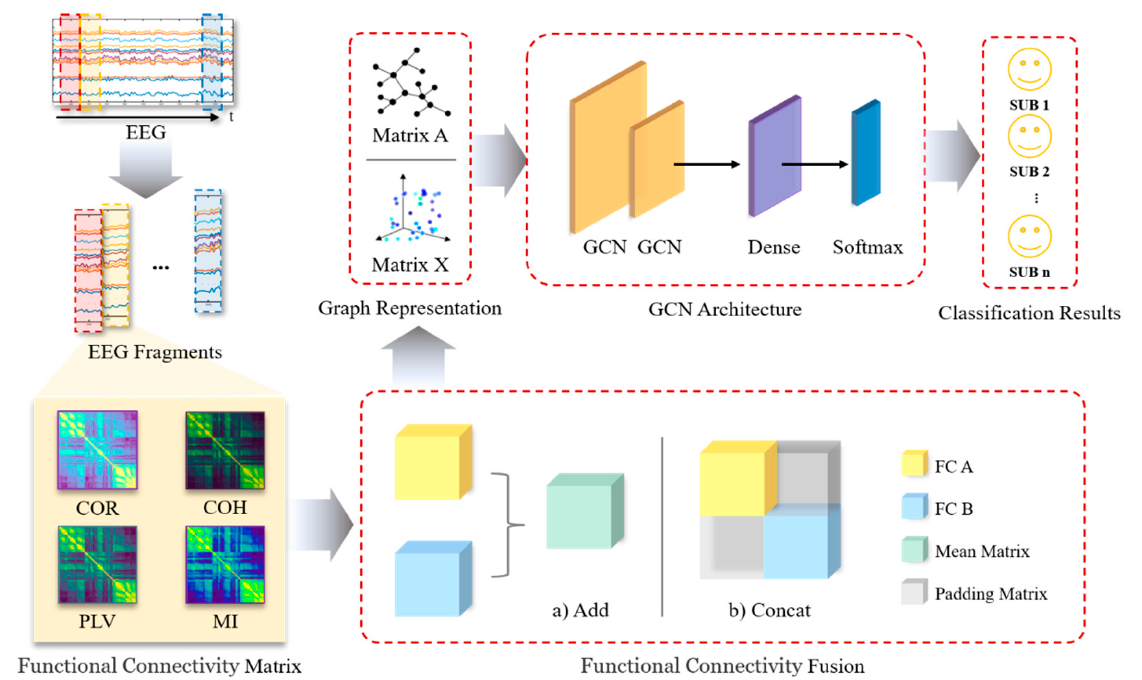
Figure 2. The flow chart of the proposed multiple features integrating method based on GCN.